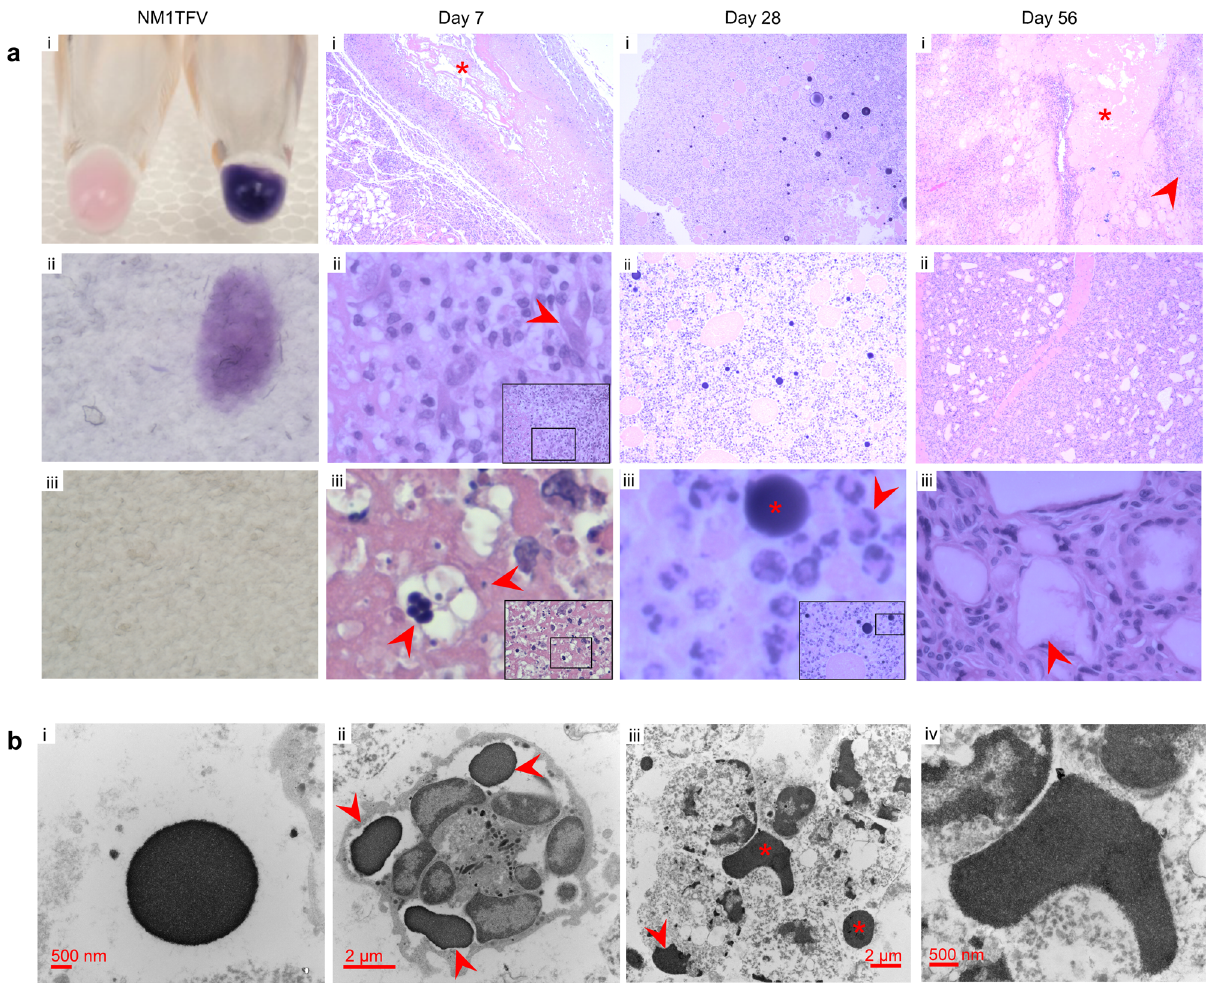
Fig. 7 Injection site histopathology. Following a single IM dose of NM1TFV or NTAF male SD rats were sacri fi ced on days 7, 28, and 56. a H&E staining of NM1TFV (i) revealed the formulation was readily stained by hematoxylin (ii), but not eosin (iii). For the histological examination of the site of injection, 5 μ M sections of paraf fi n-embedded tissues were stained with hematoxylin and eosin. Images were captured using a Nuance EX multispectral imaging system af fi xed to a Nikon Eclipse E800 microscope (Nikon Instruments). At day 7, a necrotic focus was observed (i, indicated by *), surrounded by histiocytes, and fi broblasts (ii, arrow). Clusters of foreign material, likely NM1TFV were also observed interspersed in nuclear debris (iii, arrows). By day 28, larger extracellular basophilic staining globules (iii, indicated by *) along with small basophilic intracellular granules present in the histiocytes (iii, indicated by arrow), along with foreign body granulomatous reaction. At 56 days, the foreign material appeared mostly amorphous (i, indicated by *), with a foreign body giant cell granulomatous reaction (ii, iii). b TEM images of the NM1TFV site of injection at day 28 (i & ii), and 56 (iii & iv) con fi rmed the light microscopic fi ndings. a , b Study was performed once; images are representative of the histological fi ndings from three biological replicates. Magni fi cation of each micrograph is as follows: 1×, 60×, 60× for NM1TFV i, ii, iii, respectively. 4×, 20×, 40× for Day 7 i, ii, iii, respectively. 4×, 10×, 40× for Day 28 i, ii, iii, respectively. 4×, 4×, 40× for Day 56 i, ii, iii,